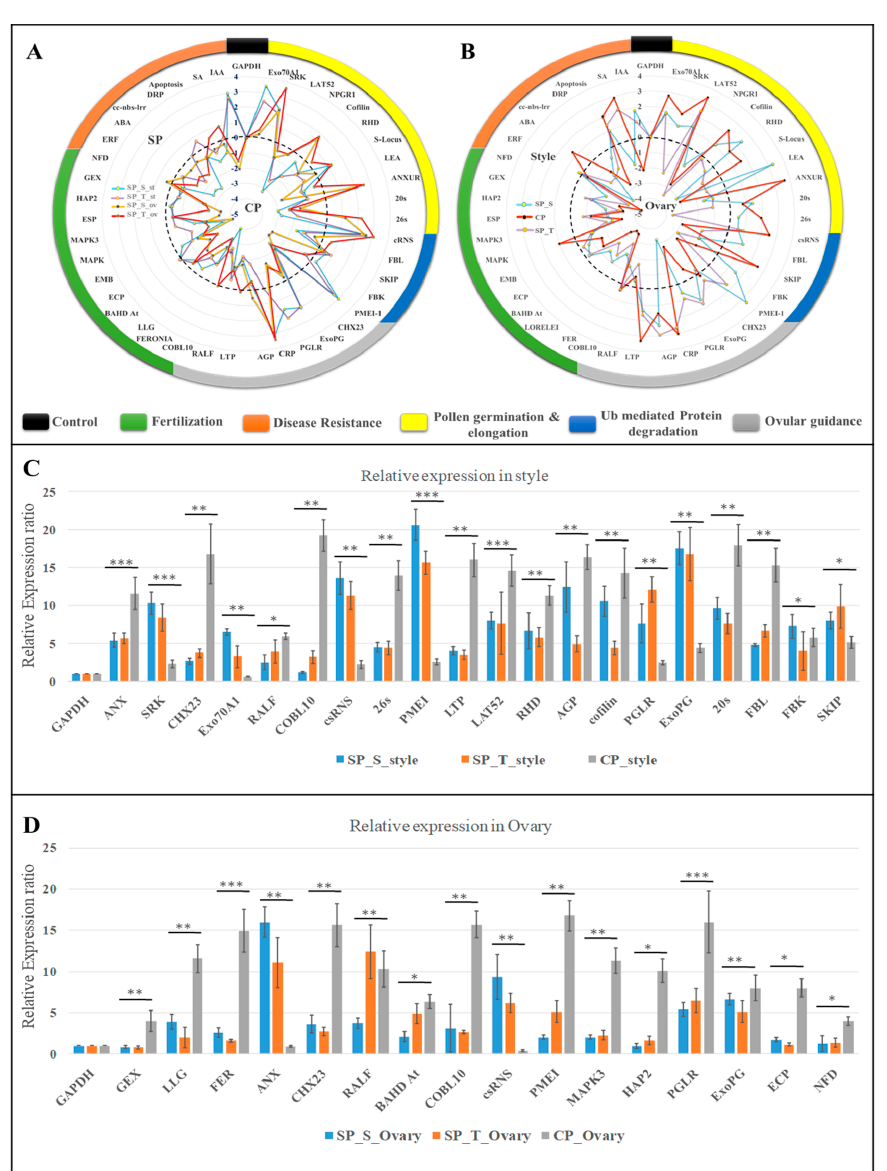
Figure 7. qRT-PCR expression analysis (log 2 fold change) of 42 key genes using GAPDH as internal control in event specific ( A ) and tissue specific ( B ) manner. The positive values (periphery) represent genes upregulated in SP and style, while negative (center) represents upregulation in CP and ovaries. ( C ) Significant relative expression of genes in self and cross-pollinated style and; ( D ) ovaries with respect to unpollinated style and ovaries respectively. The error bar in the graph represents SD of relative expression for three replicated experiments and significance level is represented as symbols (“***”, “**”, “*”) <=> p -values (0.001, 0.01,